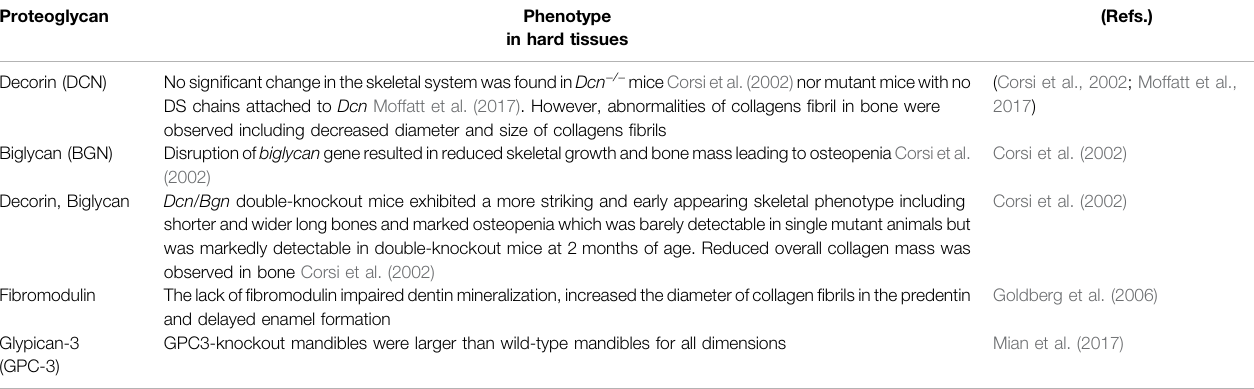
TABLE 2 | Proteoglycans de fi cient animal models with skeletal phenotypes.